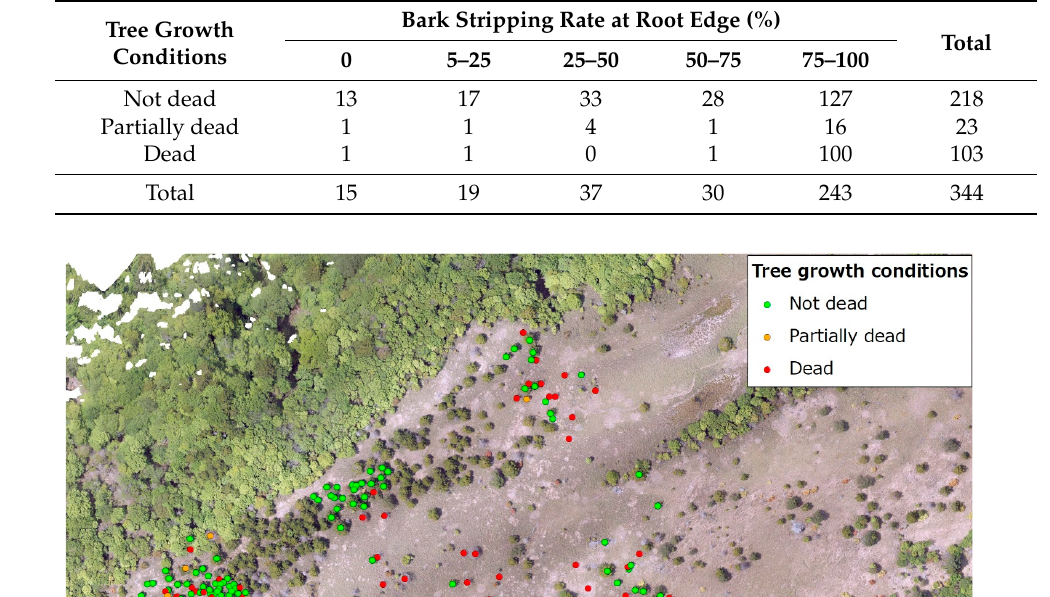
Table 1. Relationship between growth conditions and bark stripping rate at the root edge of A. homolepis .